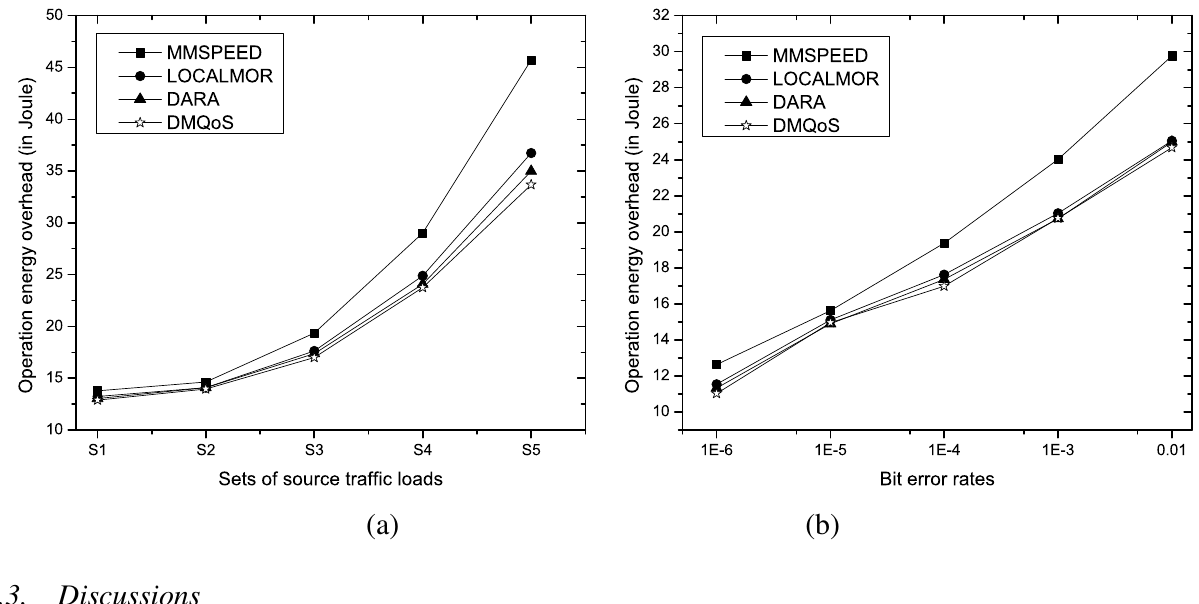
Figure 6. Protocol operation energy overhead due to routing control packets for (a) varying traffic loads and (b) bit error